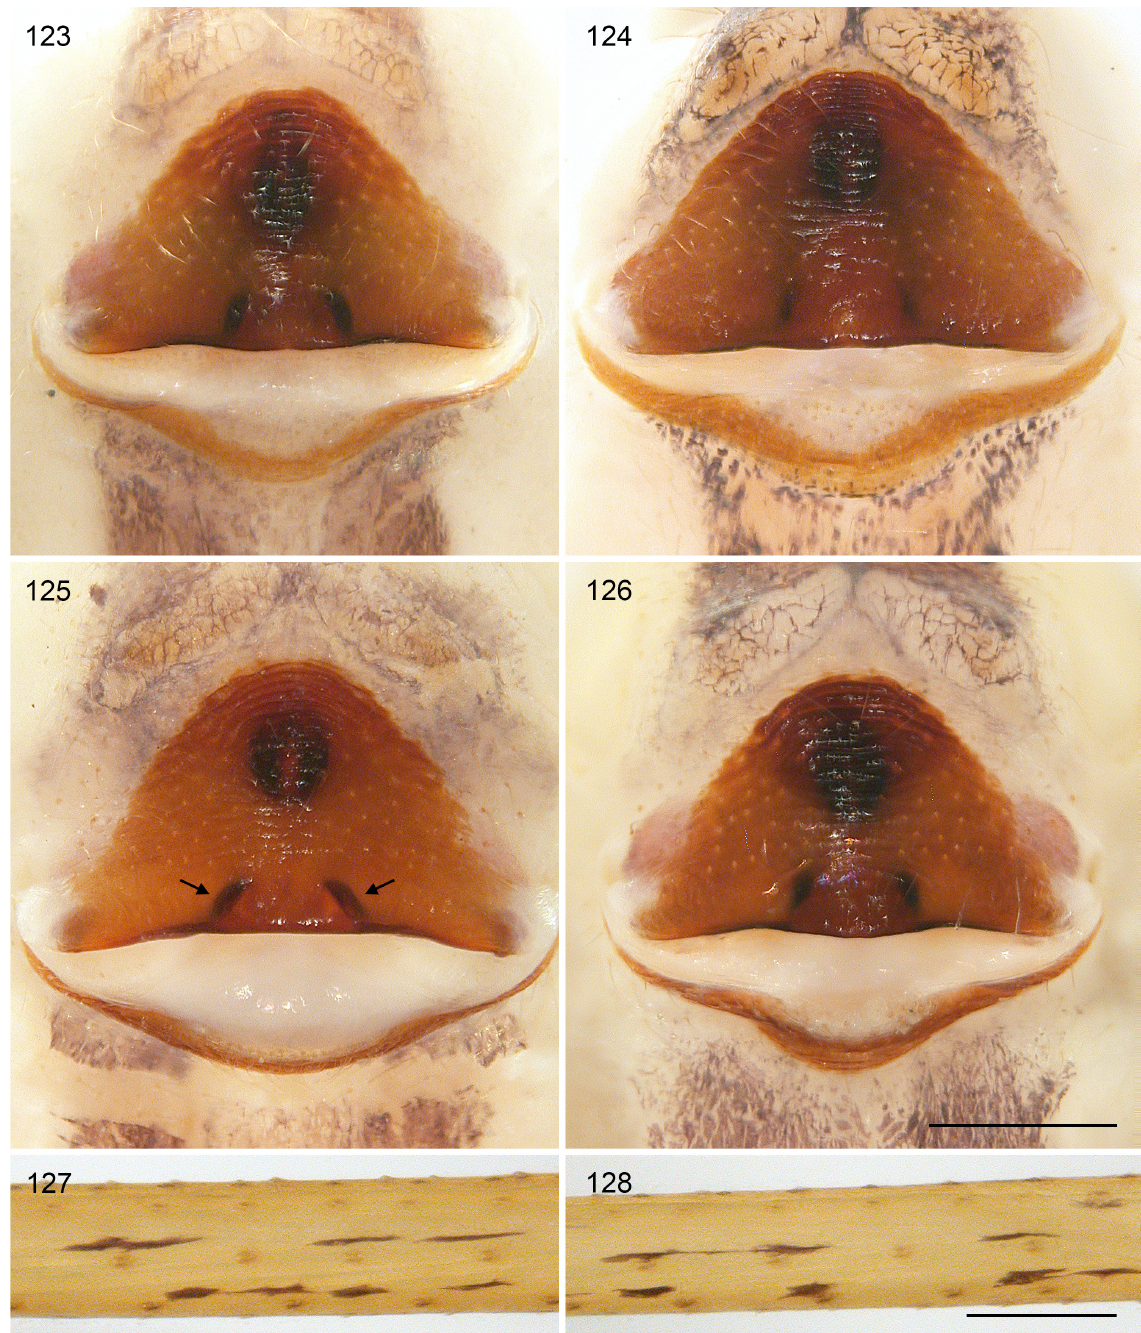
Figs 123–128. Stygopholcus photophilus Senglet, 1971; epigyna, ventral views, and details of male femora 2 and 3, dorsal views. 123 . Thessaly, Omolio, Tempi Valley (MHNG). 124 . Corfu, Loutses (MHNG). 125 . Peloponnese, Agios Dimitrios/Lefktro (MHNG); arrows point at internal sclerites. 126– 128 . Crete, Episkopi (ZFMK (Ar 22205)). Scale bars: 123–126 = 0.5 mm; 127–128 = 0.2